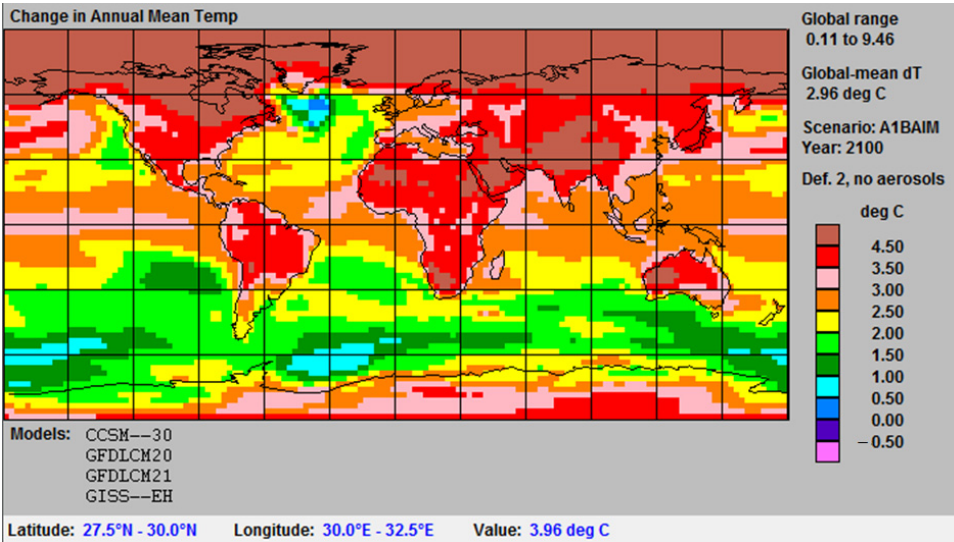
Figure 4. Change in annual mean temperature in 2100 at the regional level at latitude 27.5° N - 30.0° N and longitude 30.0° E - 32.5° E.